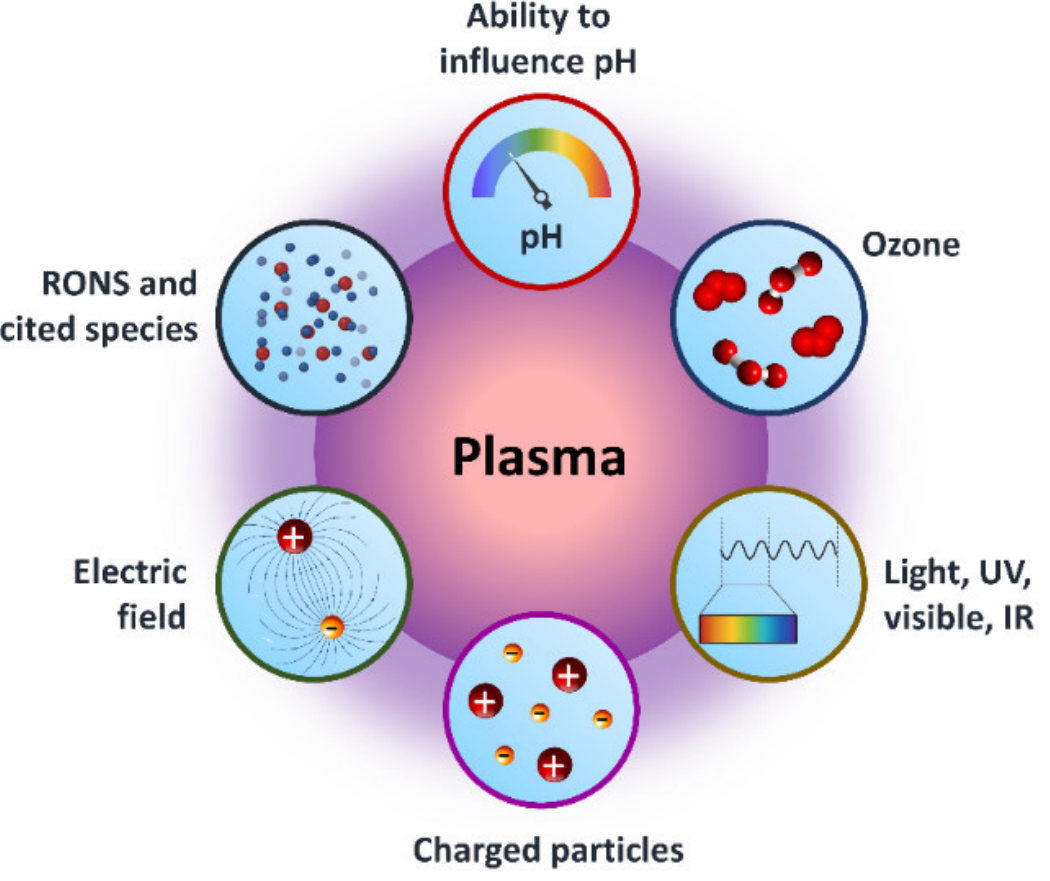
Figure 1. Graphical representation of core components of NTP for dealing with the surroundings in a variety of applications.